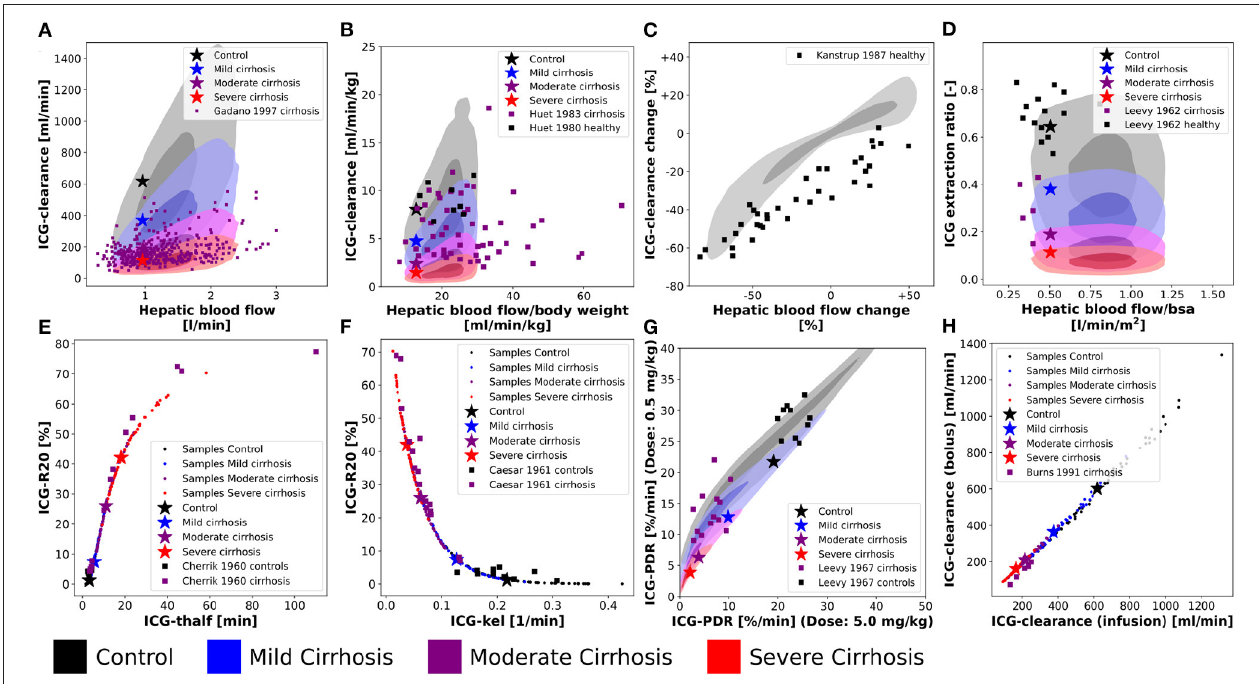
FIGURE 8 | Variability analysis-model validation: Simulations were performed for four different cirrhosis degrees [except in (C) ]. Black, control; blue, mild cirrhosis; purple, moderate cirrhosis; red, severe cirrhosis. Stars depict the respective reference simulations. (A–D,G) The identical simulations as in Figure 3 were performed for the entire in silico population ( n = 100,000). (E,F,H) Simulations were performed for a subset of the in silico population ( n = 50). (E) Correlation between ICG-R20 and ICG-t 1 / 2 . Clinical data of control and cirrhotic subjects from Cherrick et al. (1960). (F) Correlation between ICG-R20 and ICG-kel. Clinical data of control and cirrhotic subjects from Caesar et al. (1961). (G) Correlation between ICG-PDR after an ICG dose of 0.5 mg/kg and 5.0 mg/kg. Clinical data of control subjects and liver cirrhosis from Leevy et al. (1967). (H) Correlation between ICG-clearance after a bolus administration and a constant infusion of ICG. Clinical data of cirrhotic subjects from Burns et al.